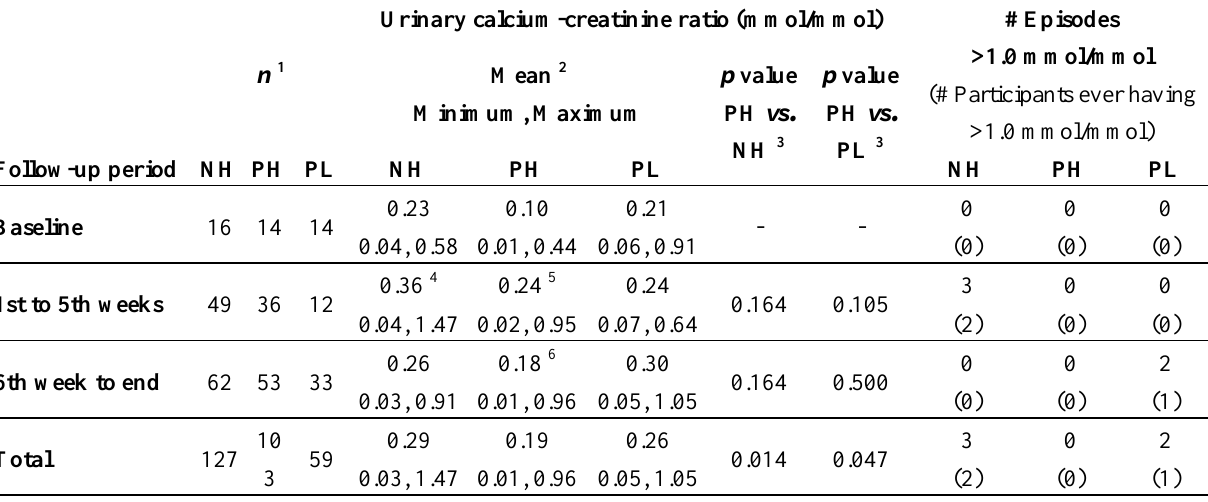
Table 5. Urine calcium:creatinine ratio in random spot urine specimens collected at baseline, 1st to 5th weeks of follow-up, and 6th week to the end of the supplementation period in non-pregnant women who received an initial dose of 70,000 IU vitamin D3 and 35,000 IU/week (NH), pregnant women who received an initial dose of 70,000 IU